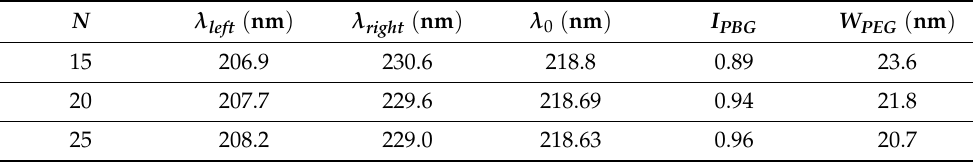
Figure 5. The effect of periodicity number for TE and TM polarizations on the reflectivity of the proposed APC ( a ), the left edge λ left , right edge λ right , and central wavelength λ 0 of the PBG ( b ), and the PBG’s width W PEG and average intensity I PBG ( c ). Table 1. The impact of the periodicity number on the PBG